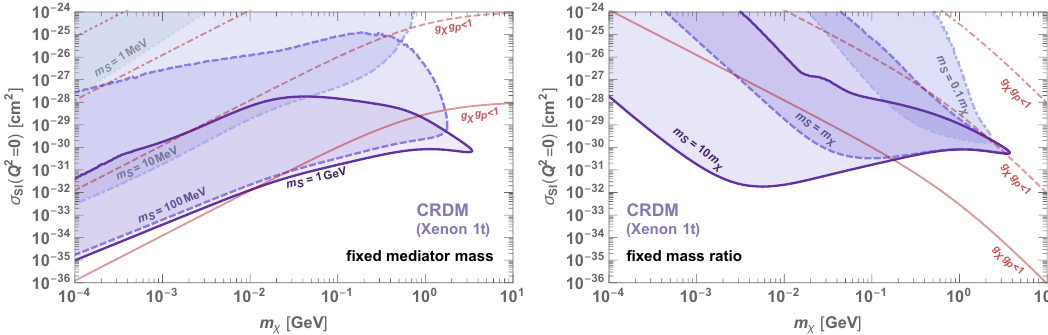
Figure 2 . Left panel . Direct detection constraints on dark matter accelerated by cosmic rays for (cid:12)xed mediator masses. Cross sections below the lower boundaries lead to recoil rates too small to be detectable, while cross sections above the upper con(cid:12)ning boundaries prevent the dark matter particles to reach the detector, due to e(cid:14)cient scattering in the overburden. As a rough indication of how large cross sections are in principle possible, we also show in each case the parameter range where the couplings are well inside the perturbative regime (for a more detailed treatment, see ref. [100]). Right panel . Same, for (cid:12)xed mediator to DM mass